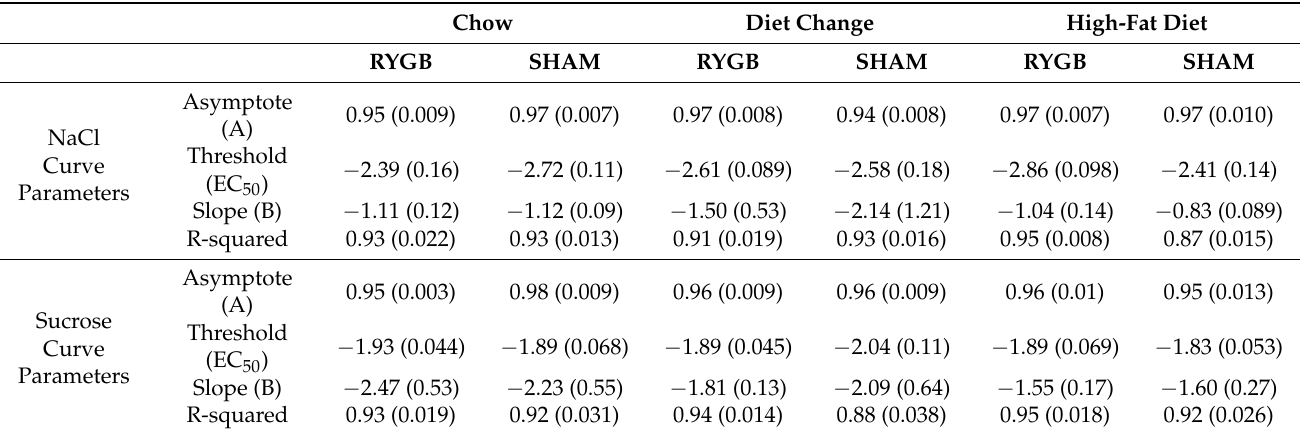
Table 6. Group means (and standard errors) for each of the parameters included in the logistic function that was used to generate individual curve fits for NaCl and sucrose testing. Chow Diet Change SHAM RYGB SHAM RYGB SHAM